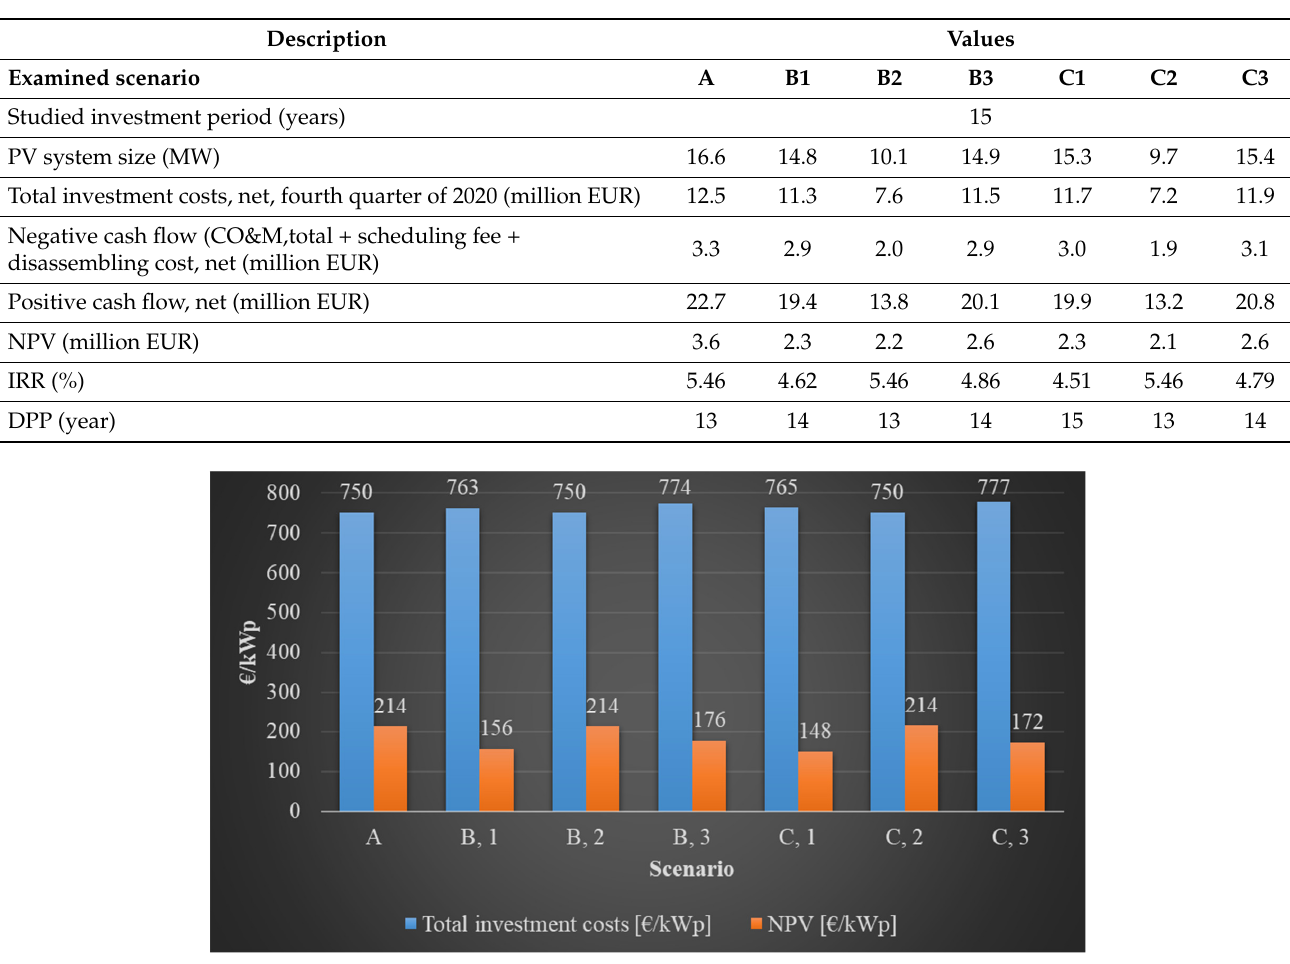
Figure 9. Comparison of the different investment alternatives studied and converted to a 1 kWp system.